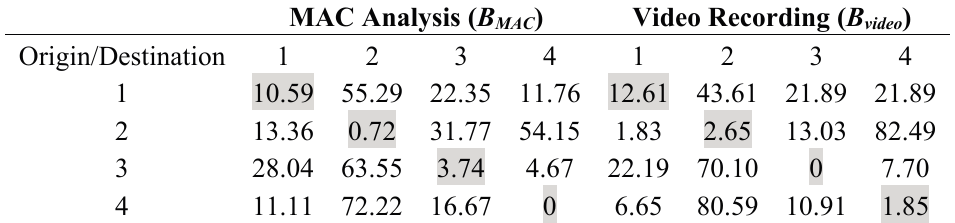
Table 4. B matrix obtained through MAC analysis compared with real